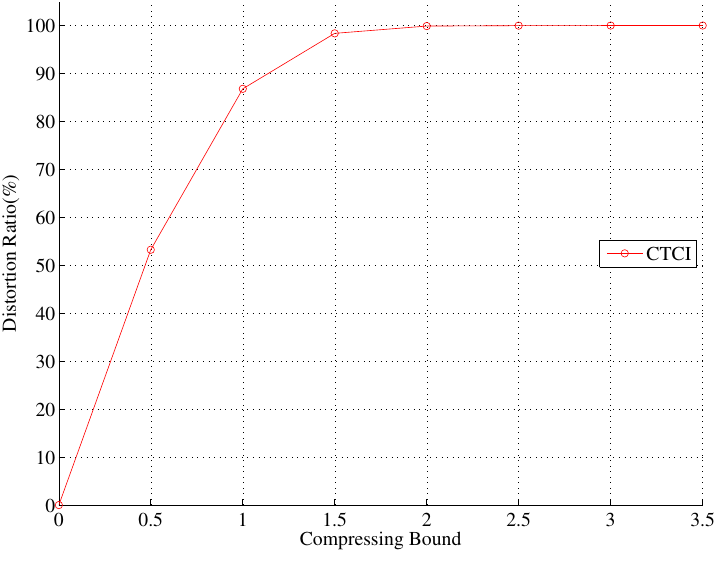
Figure 26. Impact of the compressing bound on the distortion